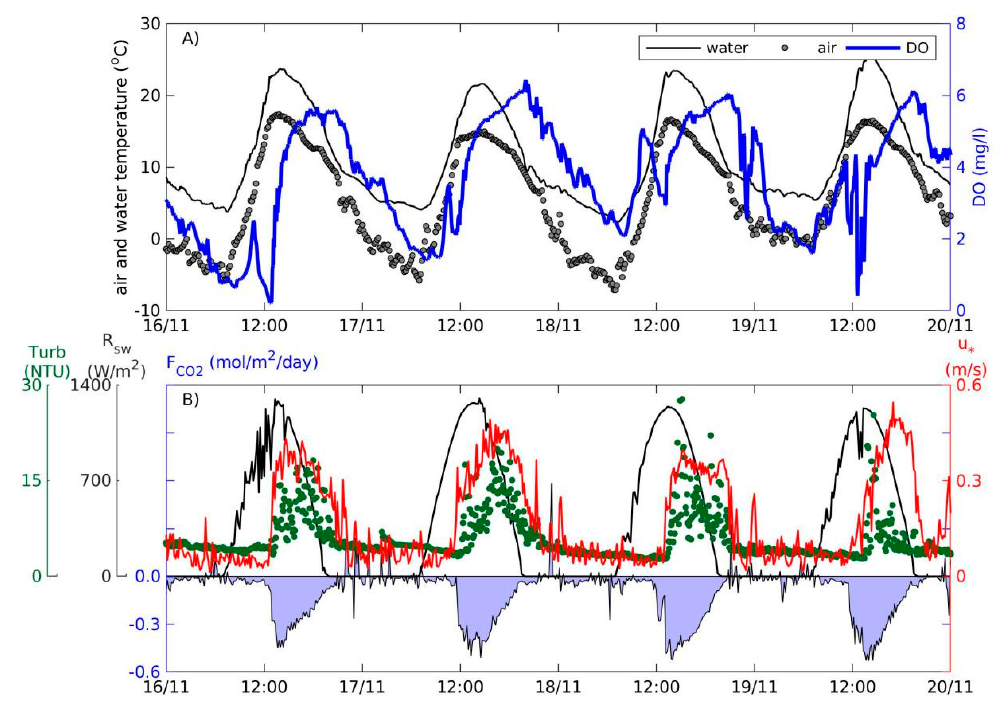
Figure 9. Field observation between 16 and 20 November 2018, in EC-water: ( A ) Time series of air and water temperature, and dissolved oxygen (DO); ( B ) time series of incident short wave radiation (R sw ), wind shear velocity (u * ), turbidity, and CO 2 flux (F CO2 ) exchanged between the air and the water (positive upward).